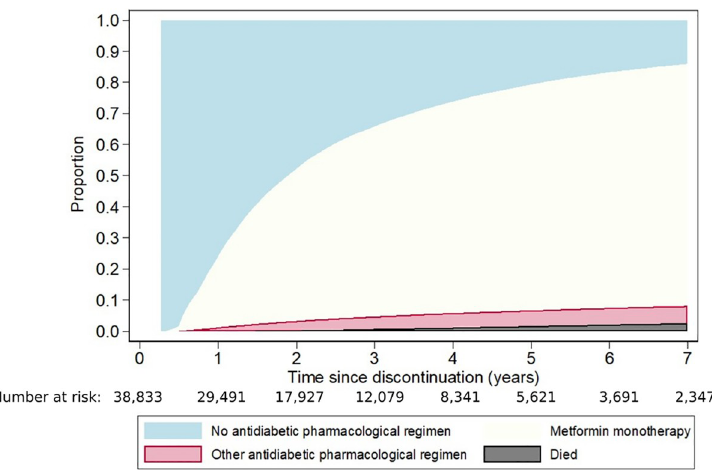
Fig 2. Cumulative proportions who reinitiated metformin monotherapy after the first discontinuation, who changed to another antidiabetic regimen, and who died.